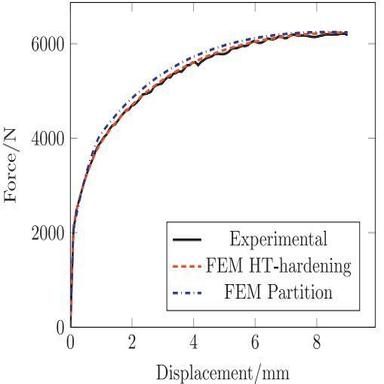
Comparison of force-displacement curves between the two THTB simulation strategies and the experimental data.